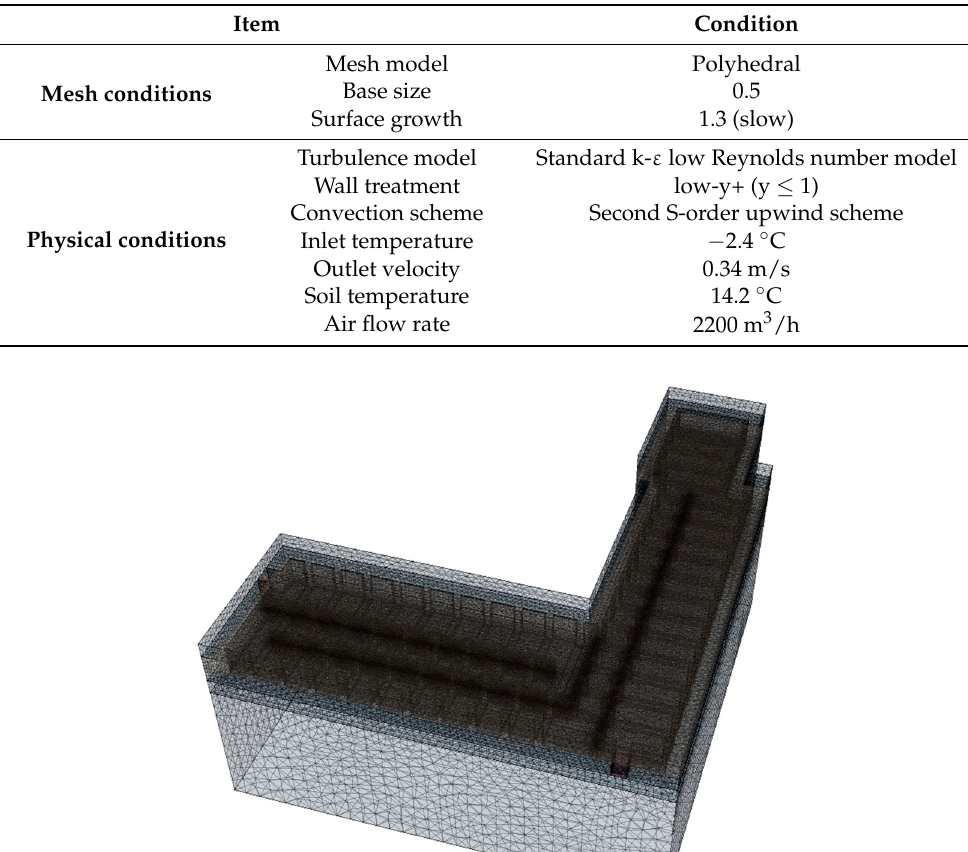
Table 6. Simulation input conditions.